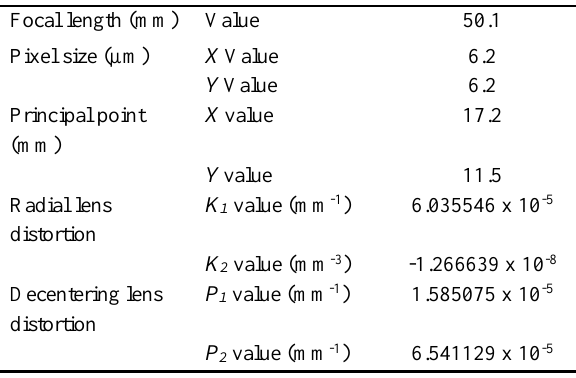
Table 2. Interior orientation parameters of visible camera Canon 5D mkII, result of its geometric